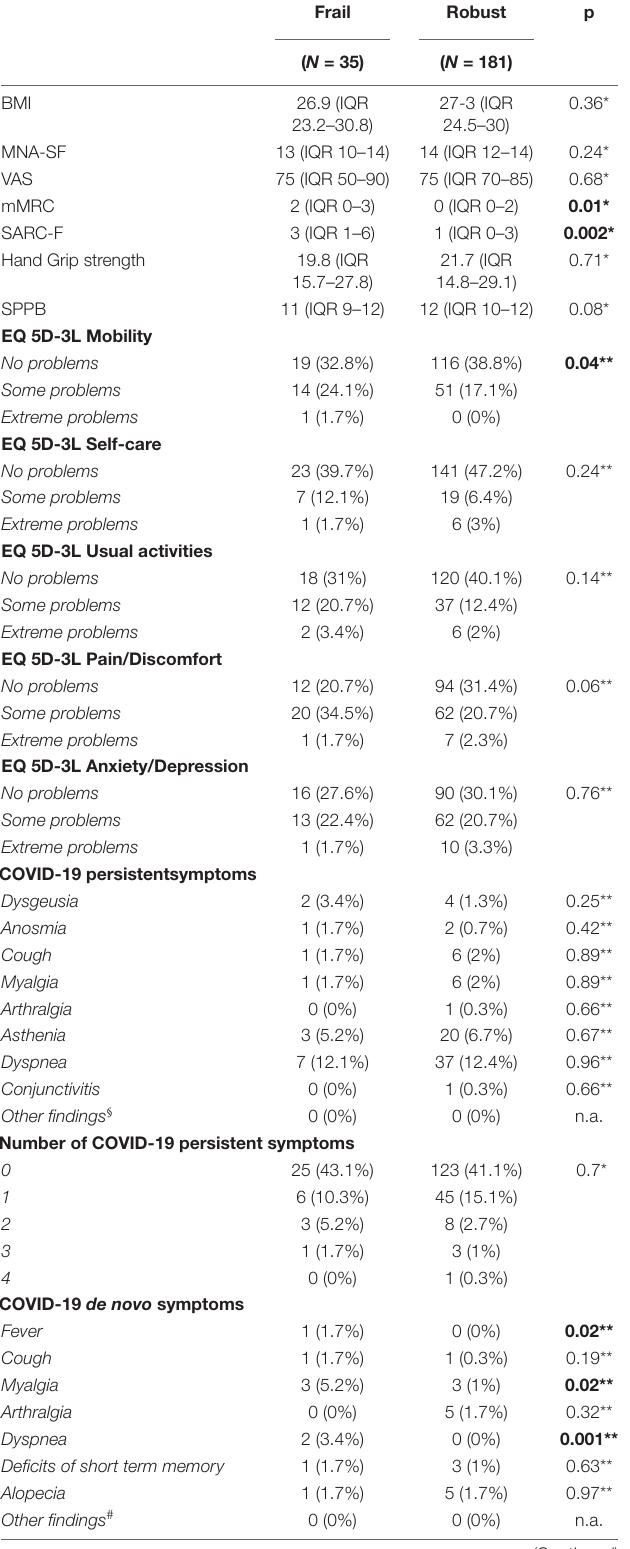
TABLE 3 | Nutritional and muscle characteristics, quality of life, and COVID-19 manifestations at the 3-month follow-up visits. Frail